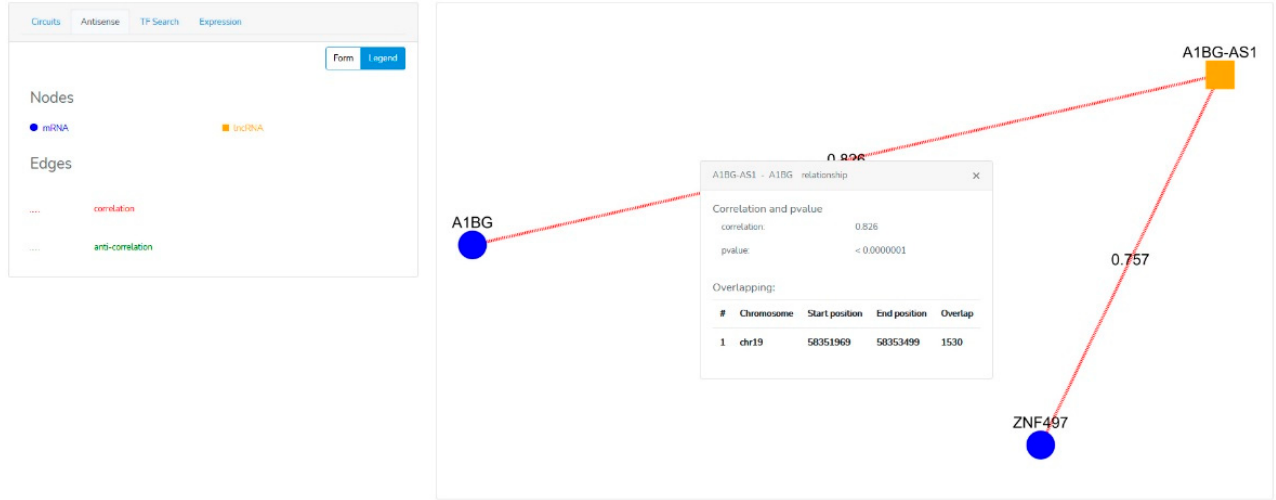
Figure 3. Result section of the VECTOR database for the “Circuits” query. Output data based on miRNA sponge activity of lncRNAs are depicted as an interactive network. UM expression data of each member of the circuits is shown as heatmap.